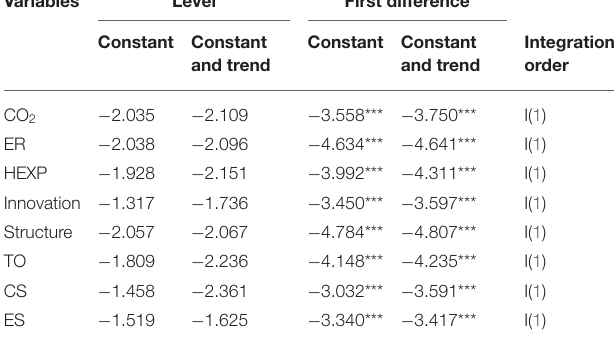
TABLE 3 | Unit root